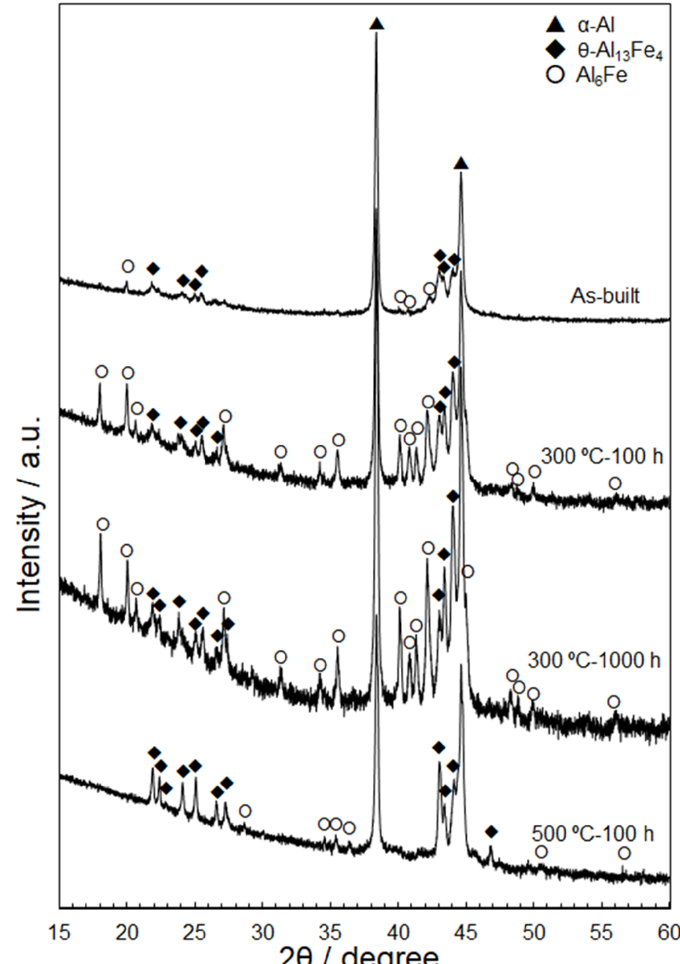
Figure 2. X-ray diffraction (XRD) profiles of the L-PBF-built pristine and thermally exposed Al–15%Fe alloy samples [300 °C (100 h, 1000 h) and 500 °C (100 h)].